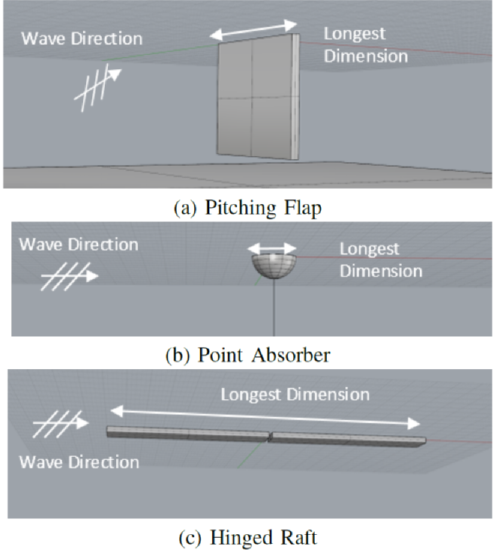
Figure 1. Image of the of the selected WEC types: pitching flap (PF), point absorber (PA), hinged raft (HR). Table 2. Overview of the selected WEC types: PF, PA,